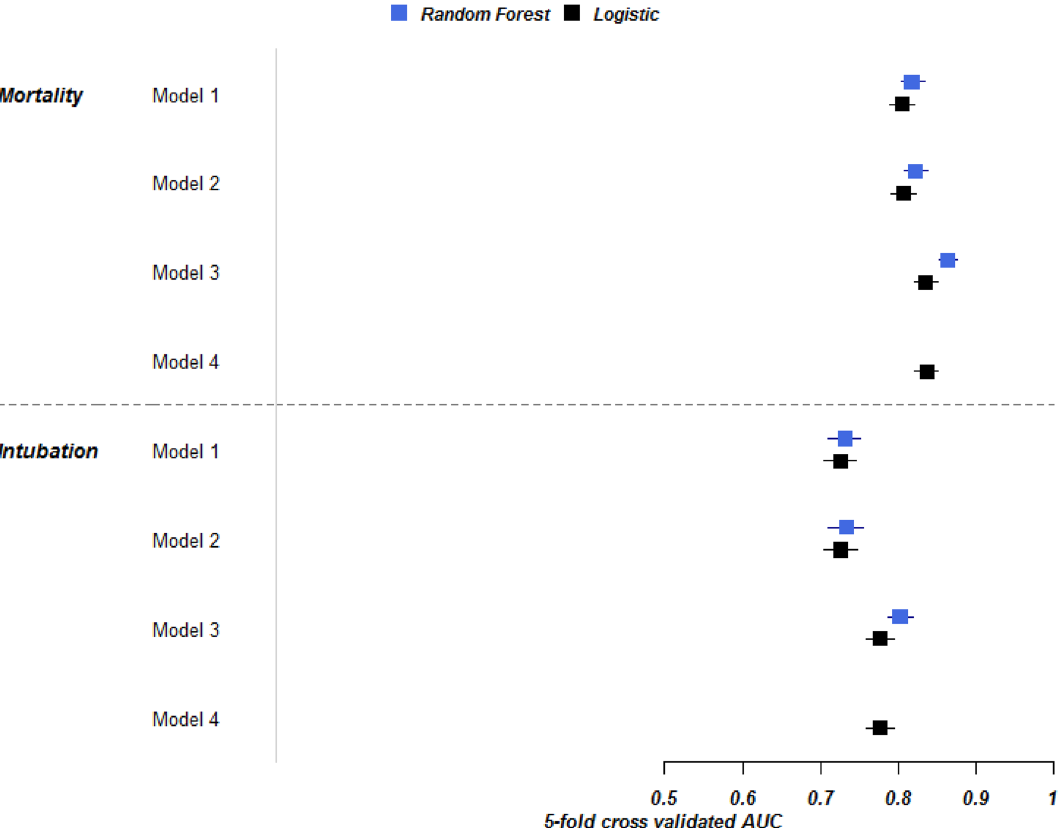
Figure 1. Fivefold cross validated AUROCs of four models using random forest (blue) and logistic regression(black). Model 1 included demographic (gender, race, age, ethnicity), vital signs (BMI, systolic and diastolic blood pressure) and comorbidities (see Table 1); Model 2 added SDI quintiles to Model 1; Model 3 added time (weeks since March 1st, 2020) to Model 2 and Model 4 (logistic regression only) added time x SDI quintile interaction to Model